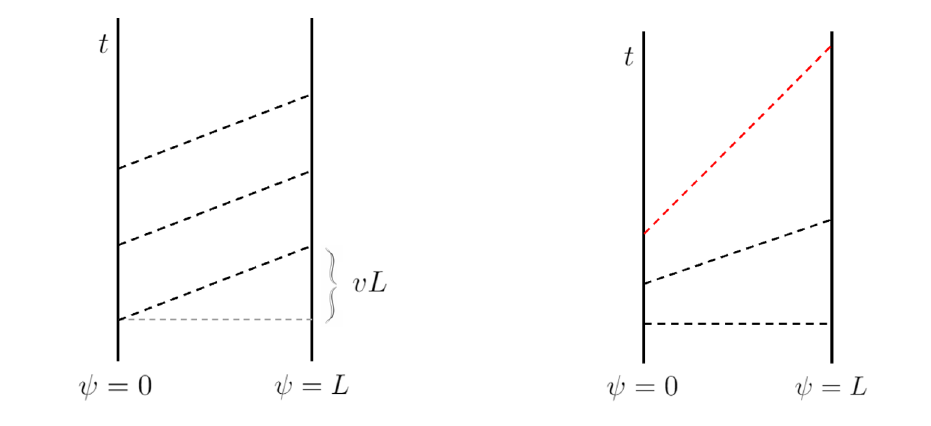
Figure 1. Left : tilted cylinder with v = const . The sides ψ = 0 and ψ = L are identified along the dashed lines, at the same time τ but different time t . Right : Misner-AdS 2 cylinder with linearly increasing v = aτ . The red line indicates that lightlike-separated points are identified, and therefore a closed null curve is present. At later times, closed timelike curves